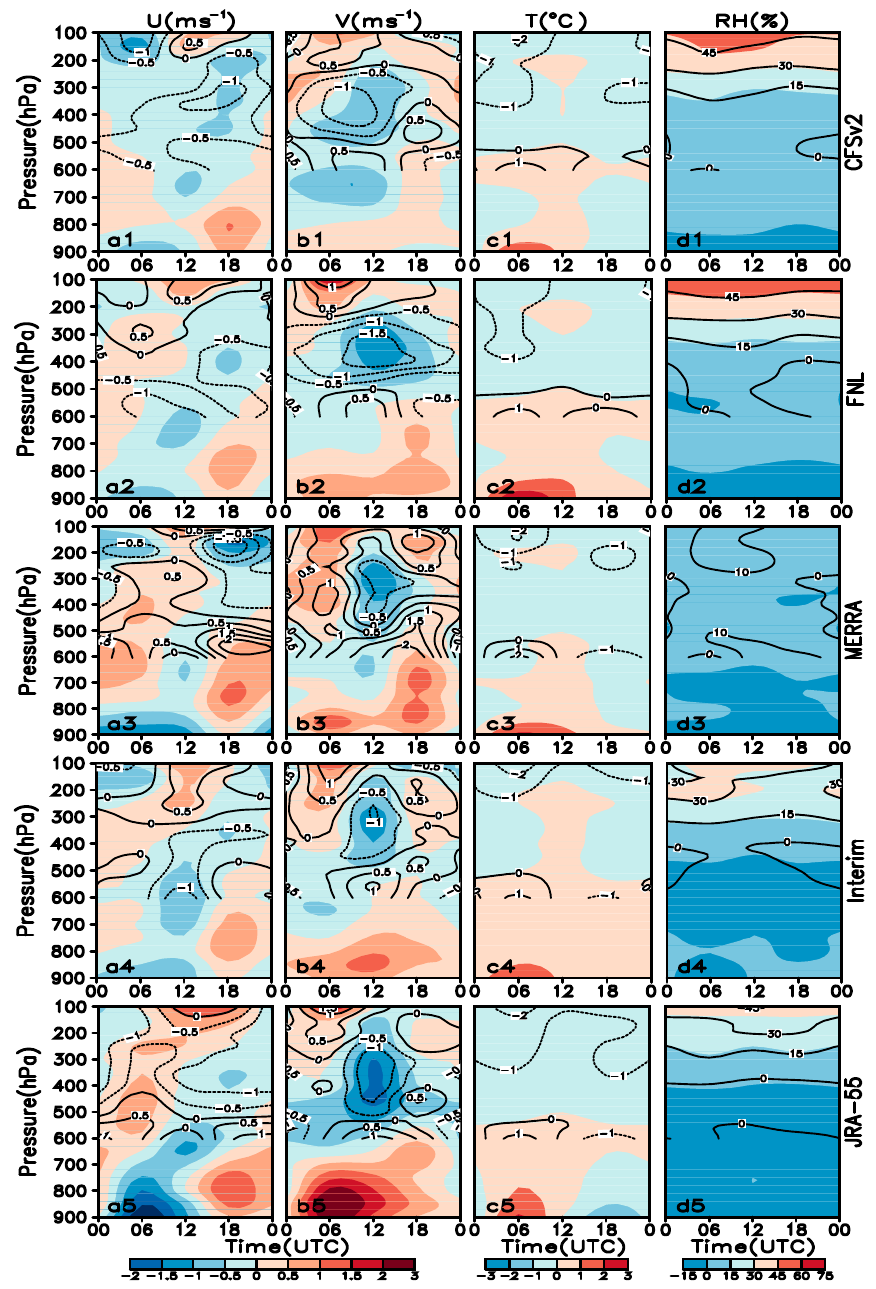
Figure 4. The diurnal variations of the mean bias of U ( a1 – a5 ), V ( b1 – b5 ), T ( c1 – c5 ), and RH ( d1 – d5 ) in the five GDs against the radiosonde data, averaged over sounding five sites in the basin (shaded) and six sites in the TP (contour) during late June–early August (2011–2015).